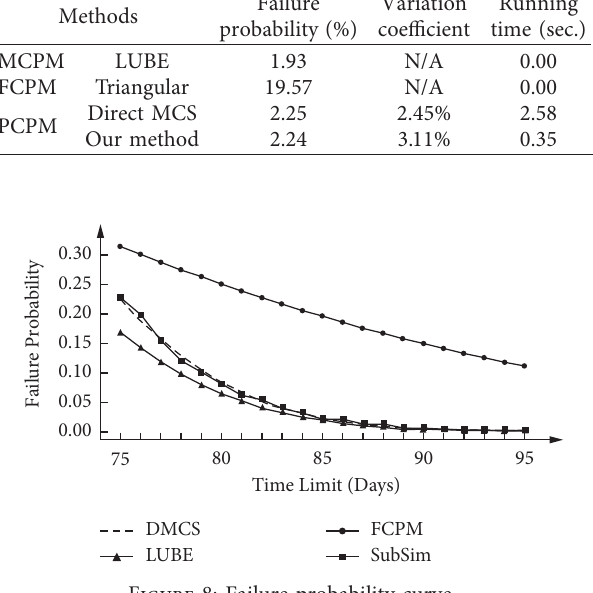
Figure 8: Failure probability curve.